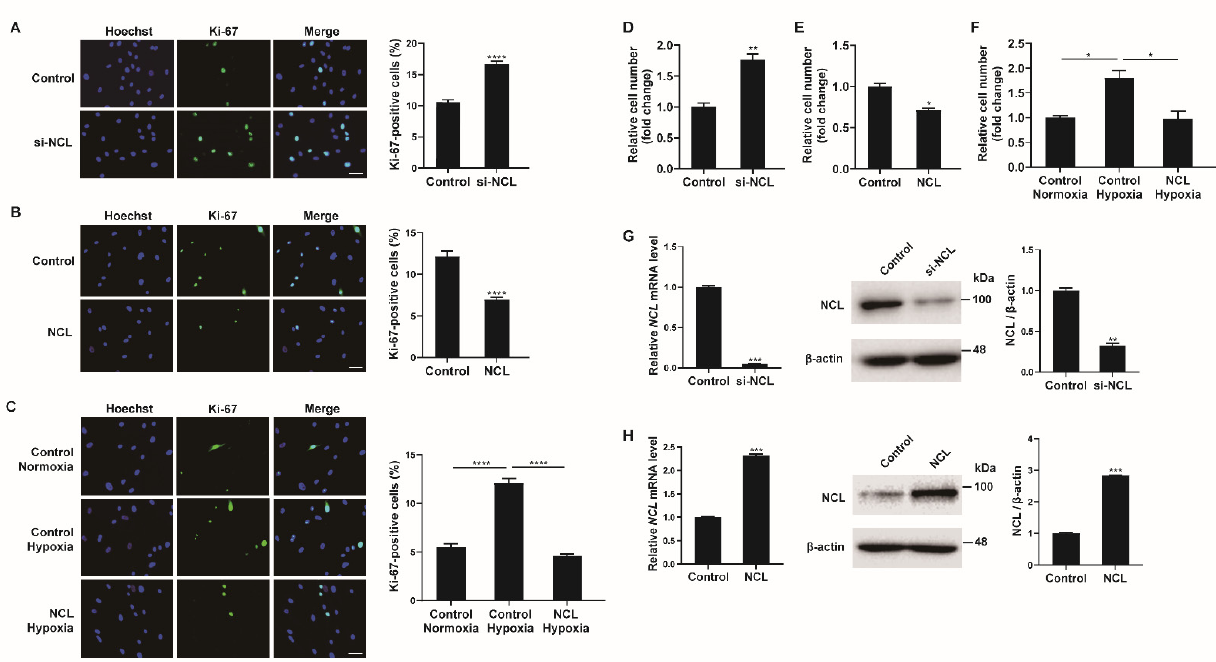
Figure 2. NCL regulates PASMC proliferation. ( A ) Representative images of Ki − 67 immunostaining of PASMCs transfected with the control or siRNA against NCL (si − NCL) and calculation of the Ki − 67 index. ( B , C ) Immunostaining analysis of PASMCs nucleofected with the empty vector control or NCL − expressing plasmids at a steady state ( B ) and after hypoxia exposure ( C ). Approximately 200 cells from at least 10 independent fields were counted for each condition, and Ki − 67-positive cells are presented as a percentage of the total population. The results are the mean ± S.E. for three independent assays. Scale bar represents 50 µ m. ( D , E ) PASMCs were transfected with control, si-NCL, an empty vector control, or an NCL − expressing vector. Cells were trypsinized and counted using a hemacytometer. The relative number of cells was shown as a fold change. ( F ) PASMCs were transfected with an empty vector control or an NCL-expressing vector, followed by hypoxia exposure and cell counting assay. ( G , H ) (Left panel) Expression levels of NCL mRNA normalized to 18S rRNA measured by qRT-PCR in PASMCs transfected with control or si − NCL for 24 h ( G ), or nucleofected with control or NCL − expressing plasmid for 24 h ( H ). (Right panel) Immunoblot analysis of lysates from NCL knockdown ( G ) or overexpressed ( H ) PASMCs with antibodies against NCL or β − actin. By densitometry, relative amounts of NCL protein normalized to β − actin were quantitated. Statistical analyses were performed using the two-tailed unpaired Stu- dent’s t -test ( A , B , D , E , G , H ) and one − way ANOVA Tukey’s multiple comparisons test ( C , F ). *, p <